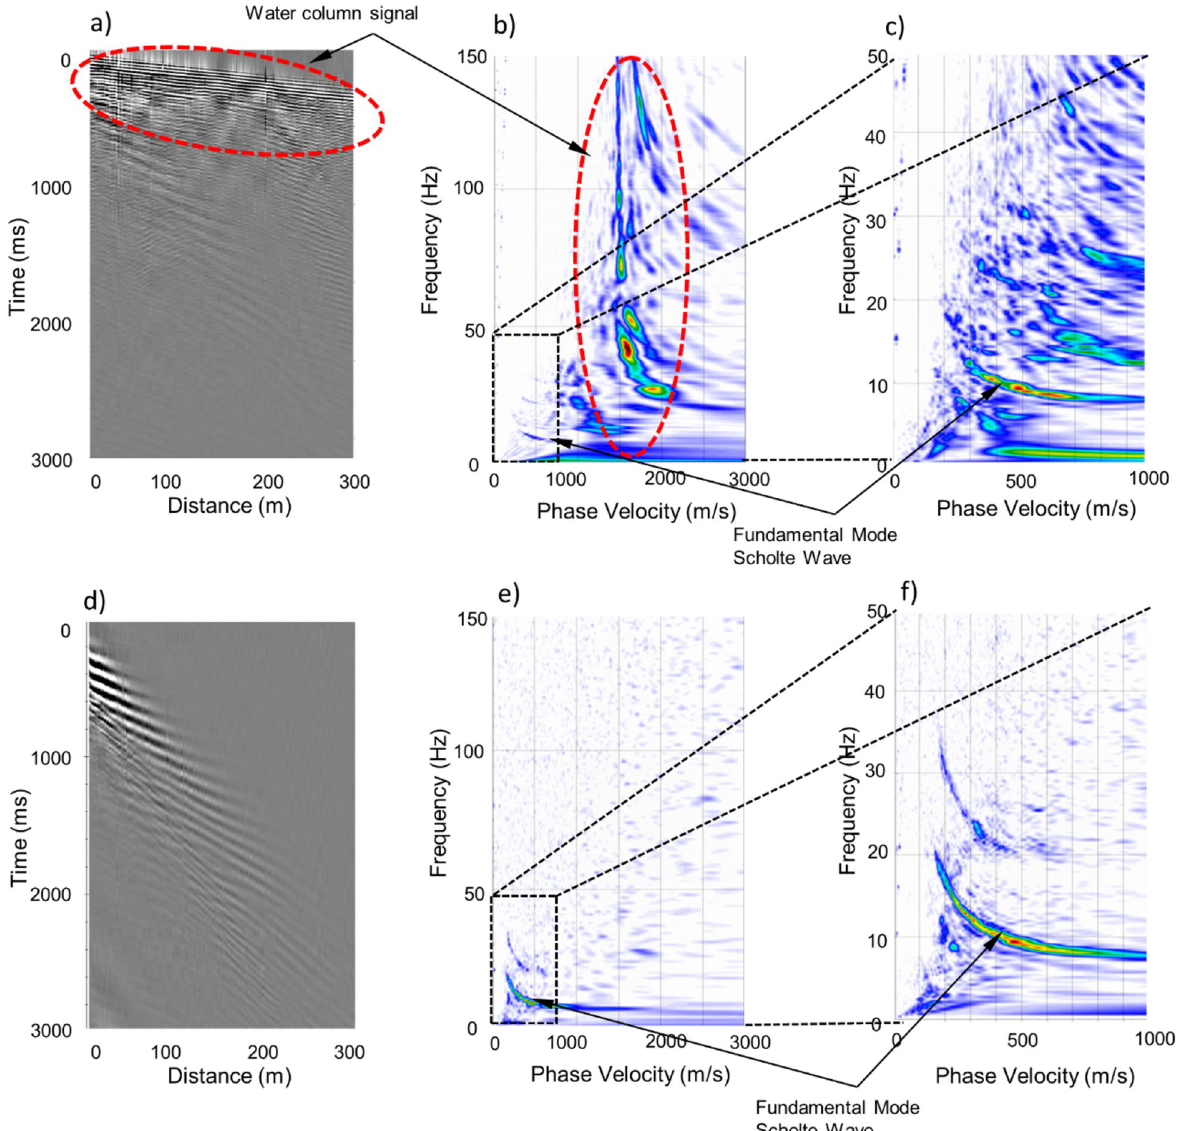
Figure 5. ( a ) Seismic shot gather and ( b , c ) corresponding dispersion images for airgun source. ( d ) Co-located seismic shot gather and ( e , f ) corresponding dispersion images for gravity corer with a System Interface Unit (SIU) and a PC to integrate the GPS timing and trigger input and to capture the recorded data. The fibre optic cable used was a Fibre Fox Uni-Tube Corrugated Steel Tape (CST) armoured loose tube variant with 4 individual single mode fibres. An OTDR was used prior to data collection to evaluate the fibre condition and check for any potentially damaging reflections at connections and spliced joints. Each pair of fibres had a spliced return at the distal end to give 2000 m of active sensing element. The cable was housed on a mechanical winch on the back deck of the Celtic Voyager. The Fionn MacCumhaill collected the distal end of the cable from the back deck and towed the cable along a predefined transect orientated to intersect the existing geotechnical data points. Once the full length of the cable was in position, the end was lowered along with a weight to fix to the seabed along with a second weight to mechanically isolate the retrieval buoy from the cable, preventing tugging noise from the buoy being transmitted along the fibre. The near end of the cable was then lowered with the same weight arrangement from the back deck of the Celtic Voyager. USBL transponders were also attached to the second weights to give real time positions of the cable ends and aid in the positioning of the gun boat in close proximity to the cable on the seabed. The airgun was lowered to the seabed at each shot point location via a hoist mounted on the source vessel. This enabled the maximum energy to be generated and transferred to the sediment / water interface. The airgun used was a 12 cu in Sercel Mini G bolt gun operated at 2000 psi. The compressed air was delivered from standard 15 l dive cylinders, via a pressure manifold unit to regulate the pressure and also maintaining the pressure in the air lines during swapping of dive cylinders, thus optimising the amount of air being used. A GAPS Ultra Short Base